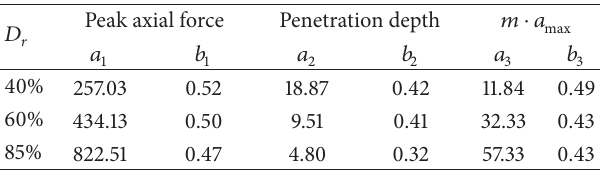
Table 5: Values of 𝑎 𝑗 , 𝑏 𝑗